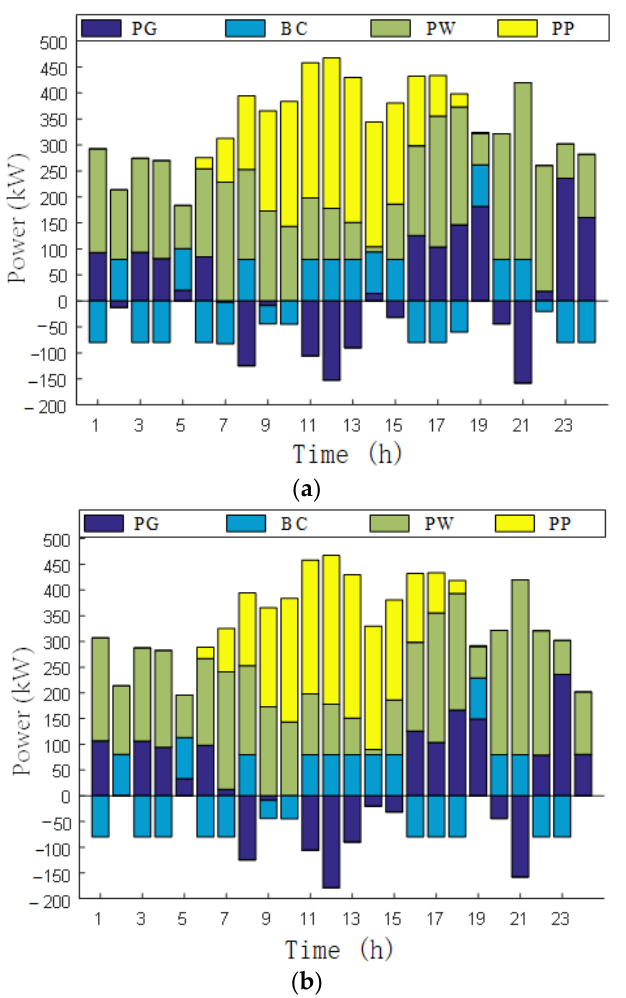
Figure 10. The optimal power results before and after DSR. ( a ) The optimal power results before DSR. ( b ) The optimal power results after DSR.